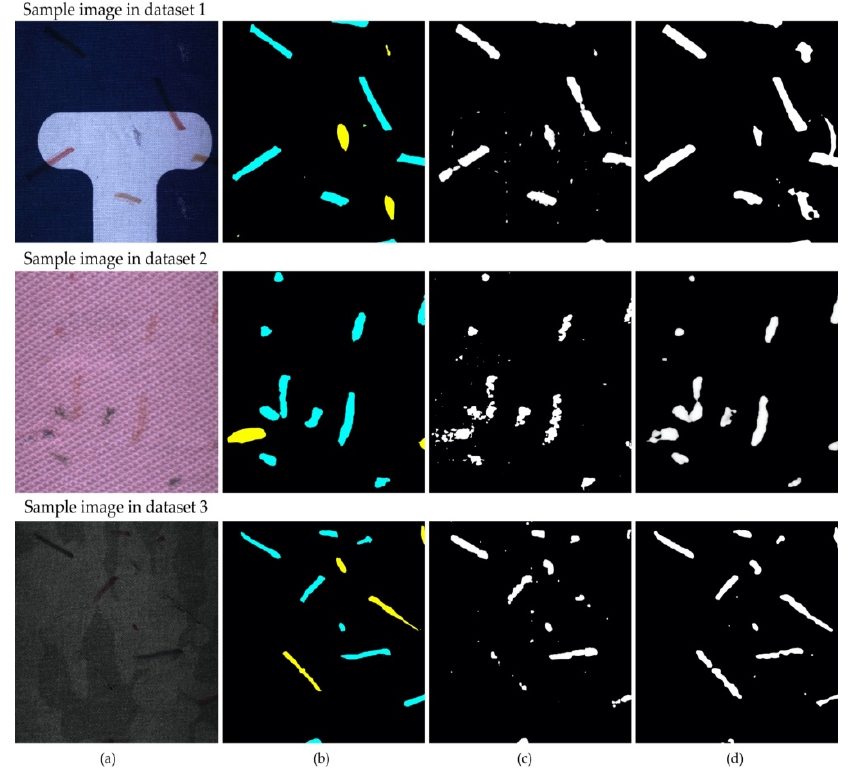
Figure 5. Performance of the proposed method: ( a) initial input image; ( b ) ground truth; ( c ) results of our method; and ( d ) results of method using U-Net.